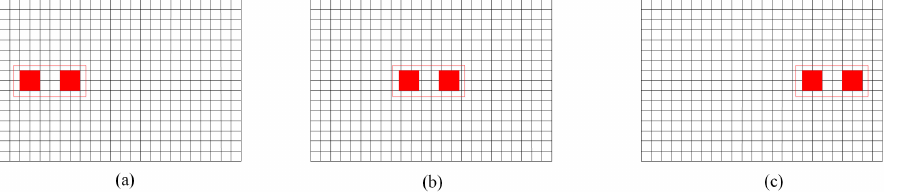
Figure 2. Alternation of LED coordinates of an FWV moving from right to left with respect to the FLV on an image sensor. ( a ) FWV is at the right side of the FLV. ( b ) FWV is straight with respect to FLV. ( c ) FWV is at the left side of